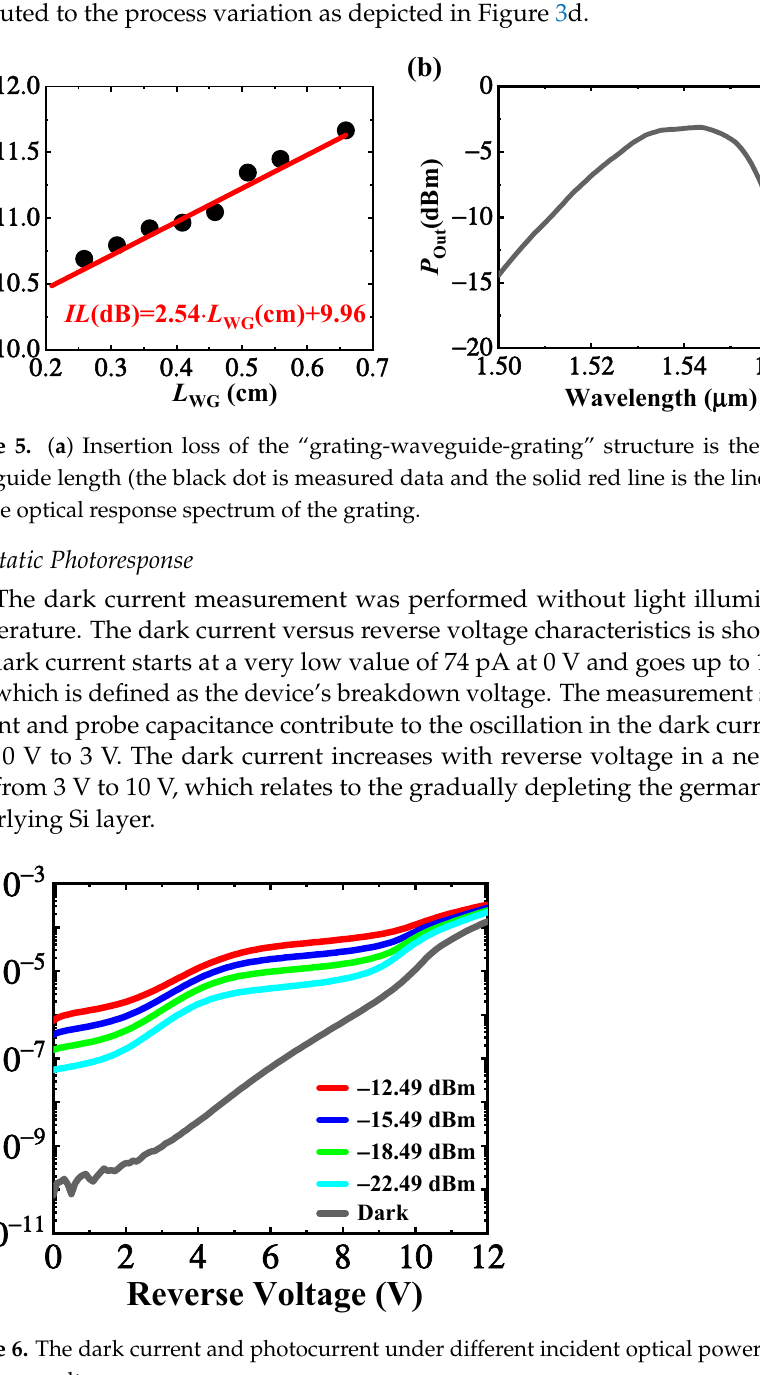
Figure 4. ( a ) Optical microscopy image of the grating; ( b ) Optical microscopy image of the active area of the device; ( c ) Cross-section SEM image of the active region; ( d ) Cross-section of the germa- nium region.